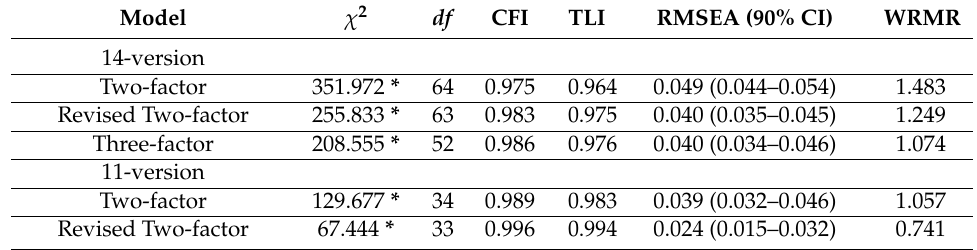
Table 3. The two- and three-factor models of exploratory structural equation modeling (ESEM) for the two